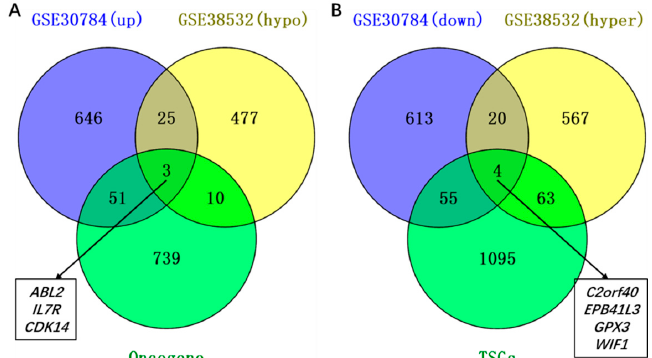
Figure 2. Identification of aberrantly methylated differentially expressed genes, and relating oncogenes and tumor suppressor genes (TSGs). ( A ) Twenty-eight hypomethylated and upregulated genes were identified, and three of them were oncogenes. ( B ) Twenty-four hypermethylated and downregulated genes were identified, and four of them were TSGs.